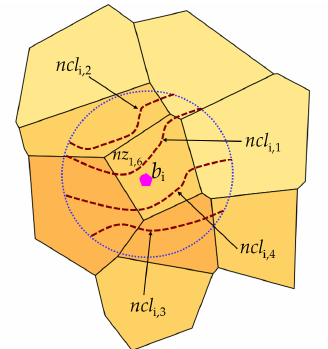
Figure 3. The nearest contour lines ( ncl i , o ; o = 1.4—the dotted lines) to building b i .